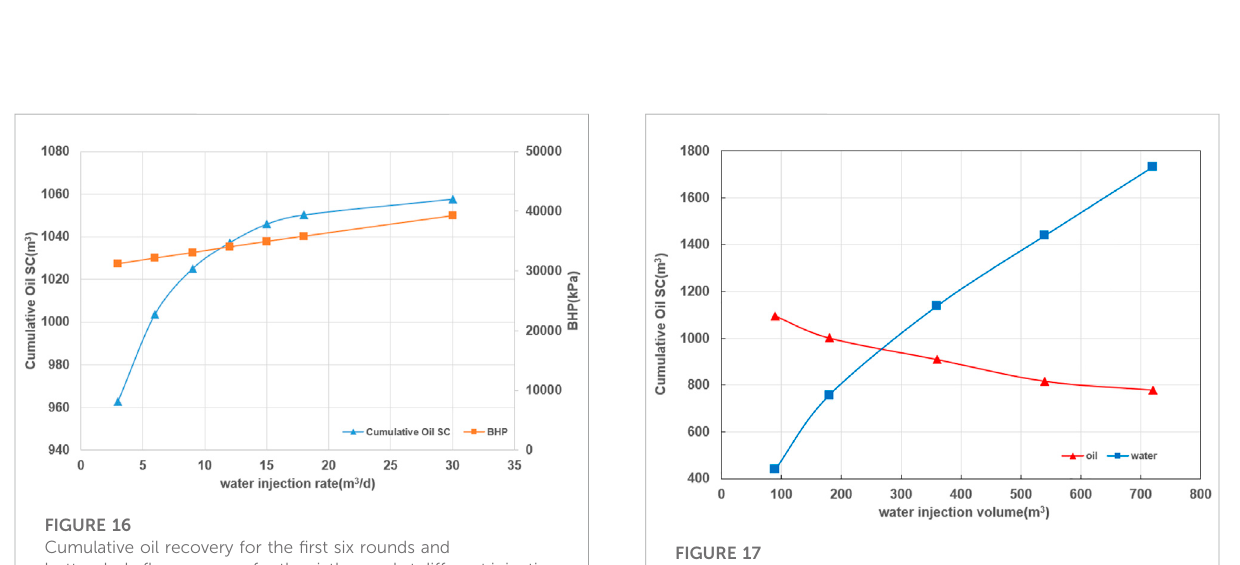
FIGURE 16 Cumulative oil recovery for the fi rst six rounds and bottomhole fl ow pressure for the sixth round at different injection rates.